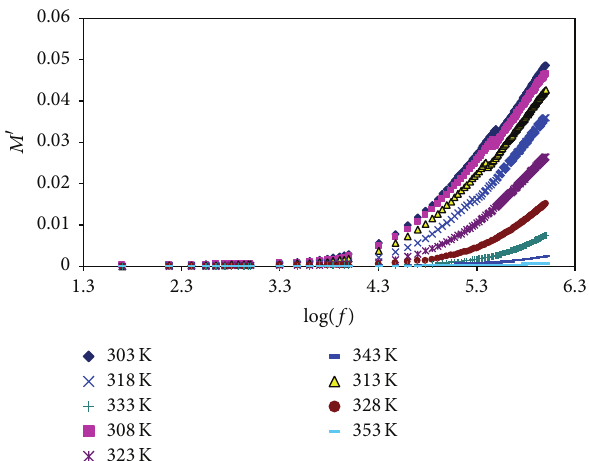
Figure 17: Frequency dependence of 𝑀 󸀠 at different temperature for CSNC2 sample.